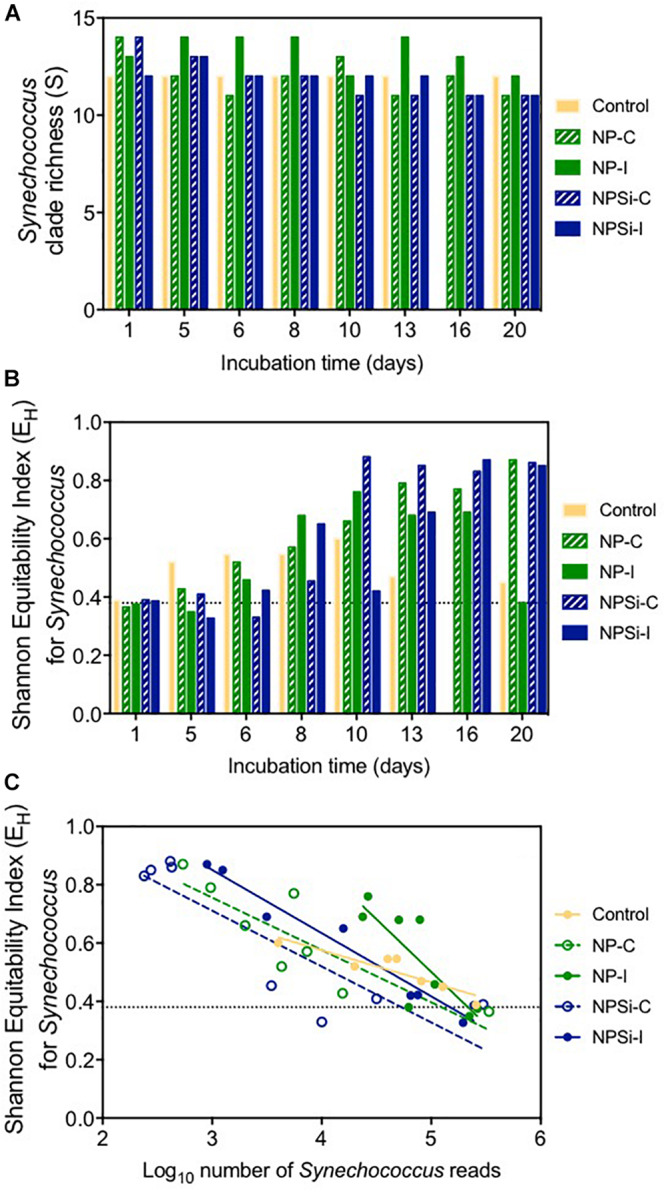
(A) Changes in Synechococcus clade richness with time (in days). Dashed line indicates the average richness at the beginning of the experiment. (B) Changes in Shannon’s equitability for Synechococcus with time (in days). Dashed line indicates the value for this index at the beginning of the experiment. (C) Relationship between Shannon’s equitability and the number of reads (in Log10) for Synechococcus.